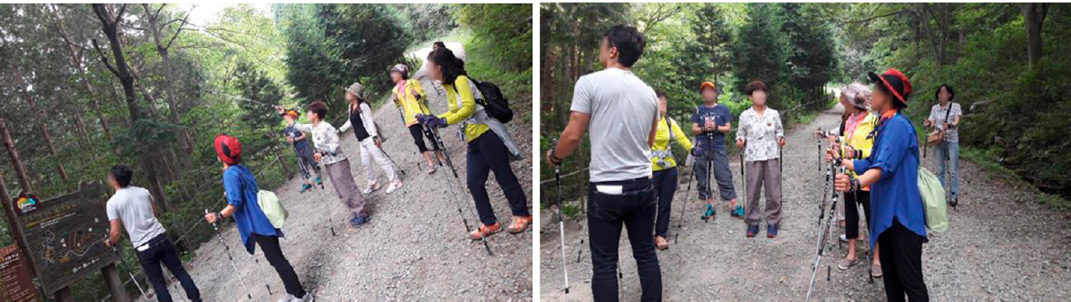
Figure 2. Forest therapy program. Participants were taking a walk in the forest and listening to explanations about tree and forest animals.